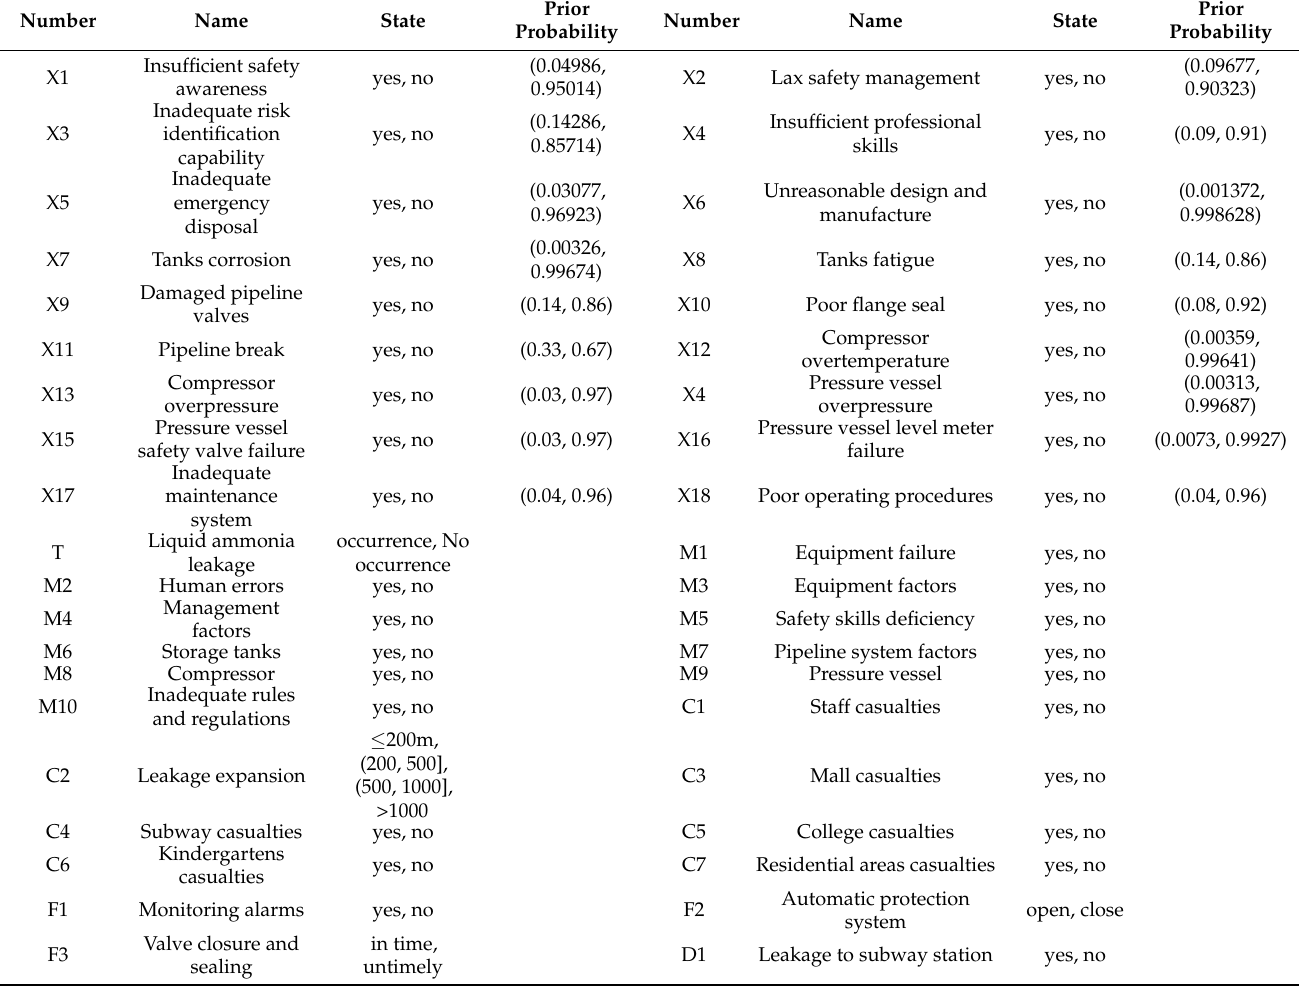
Table A1. Node name and prior probability of liquid ammonia leakage Bayesian